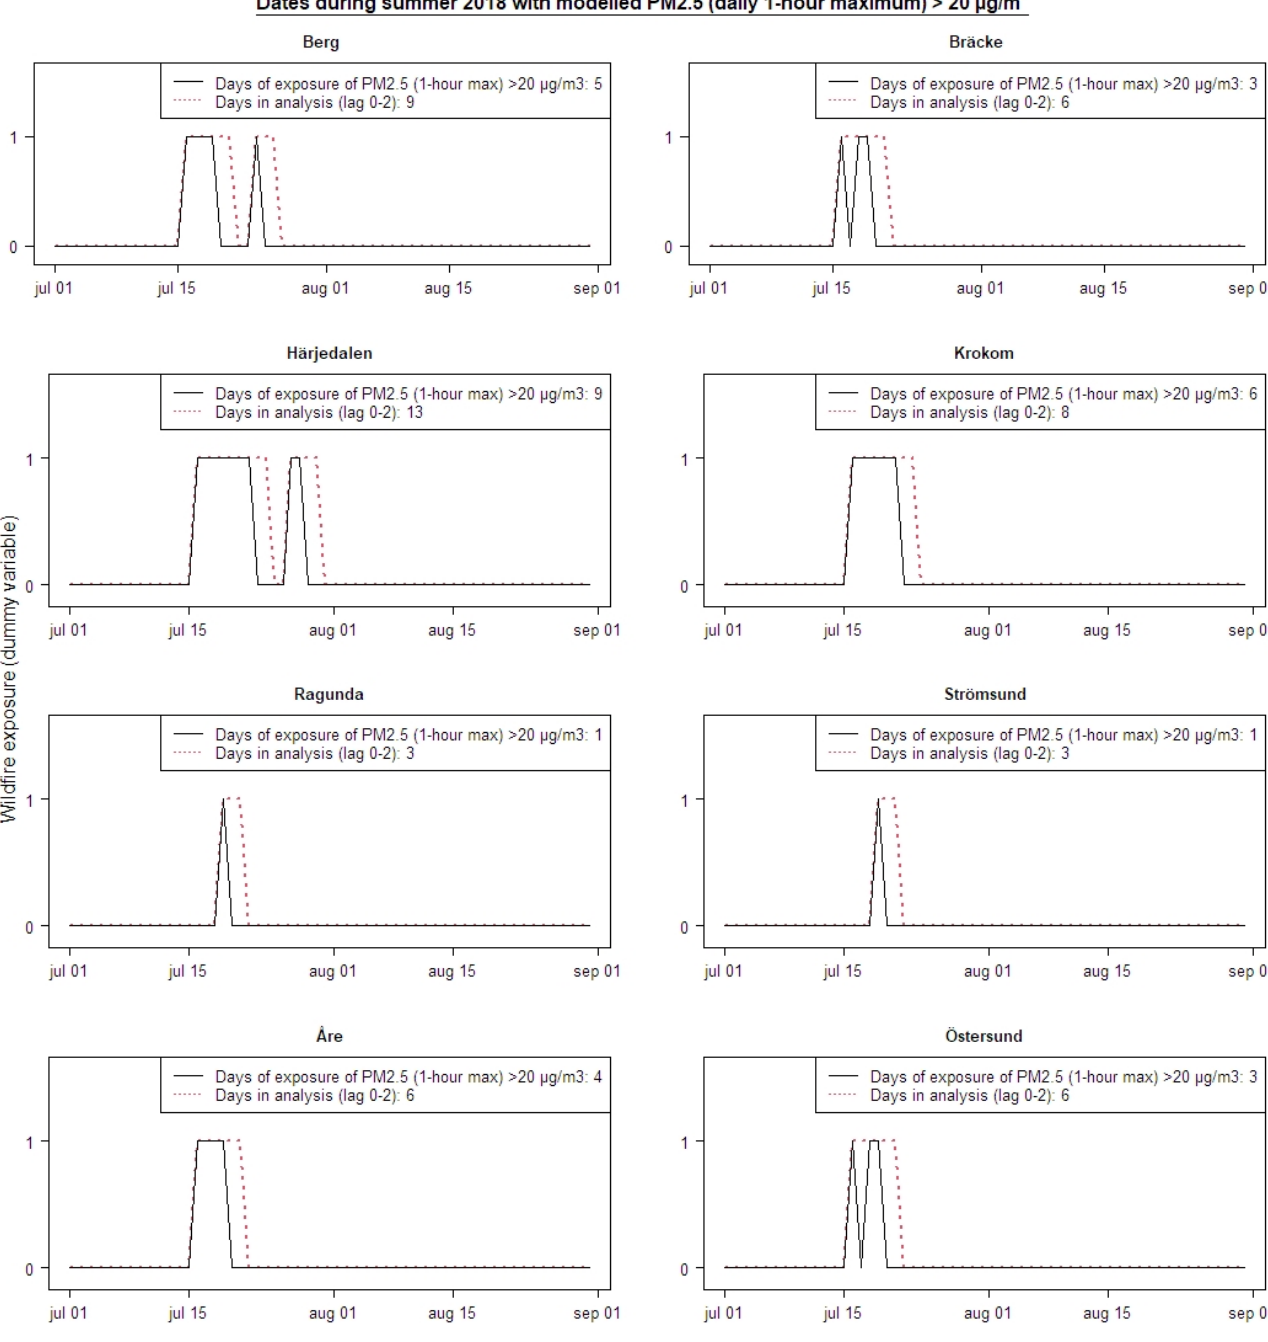
Figure 4. Dates of exposure to wildfire smoke defined as maximum 1-h mean value of PM 2.5 > 20 µ g/m 3 for 8 municipalities in the summer of 2018 (black), and dates when the number of healthcare contacts was analyzed in regression models according to a delay period of 2 days (lag 0–2) (red,